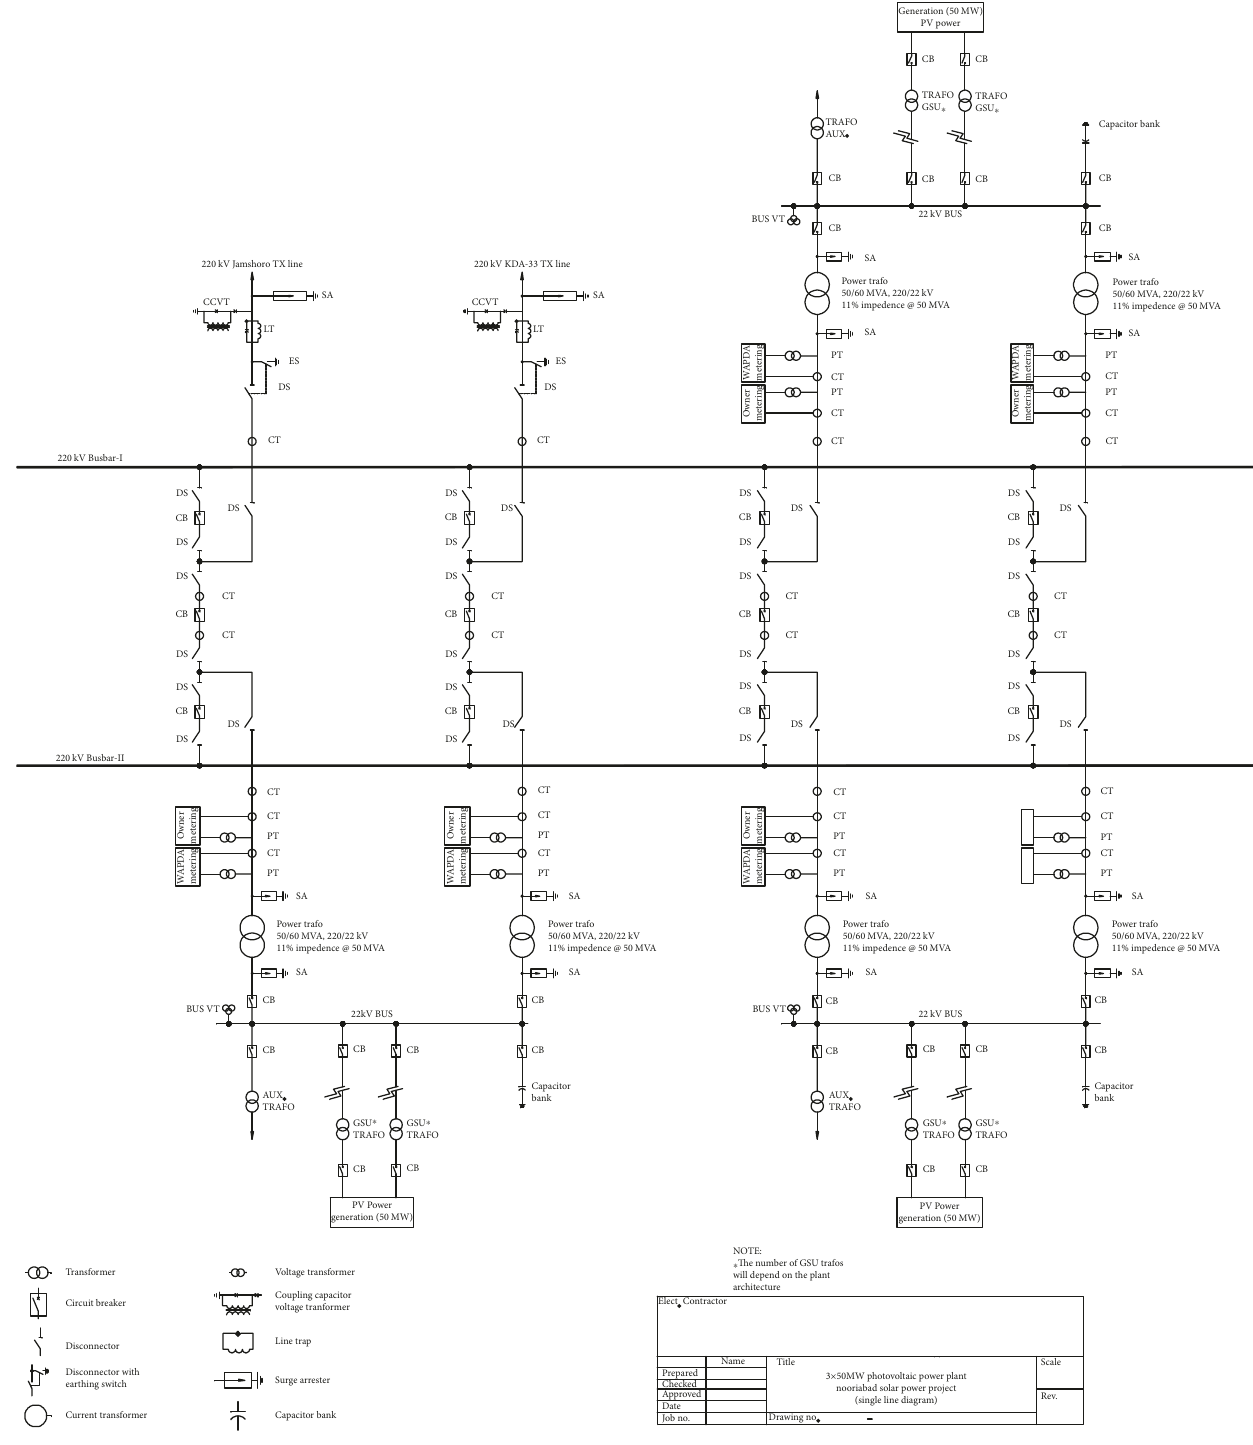
Figure 12: Main single line diagram (SLD) of 3 × 50MW PV